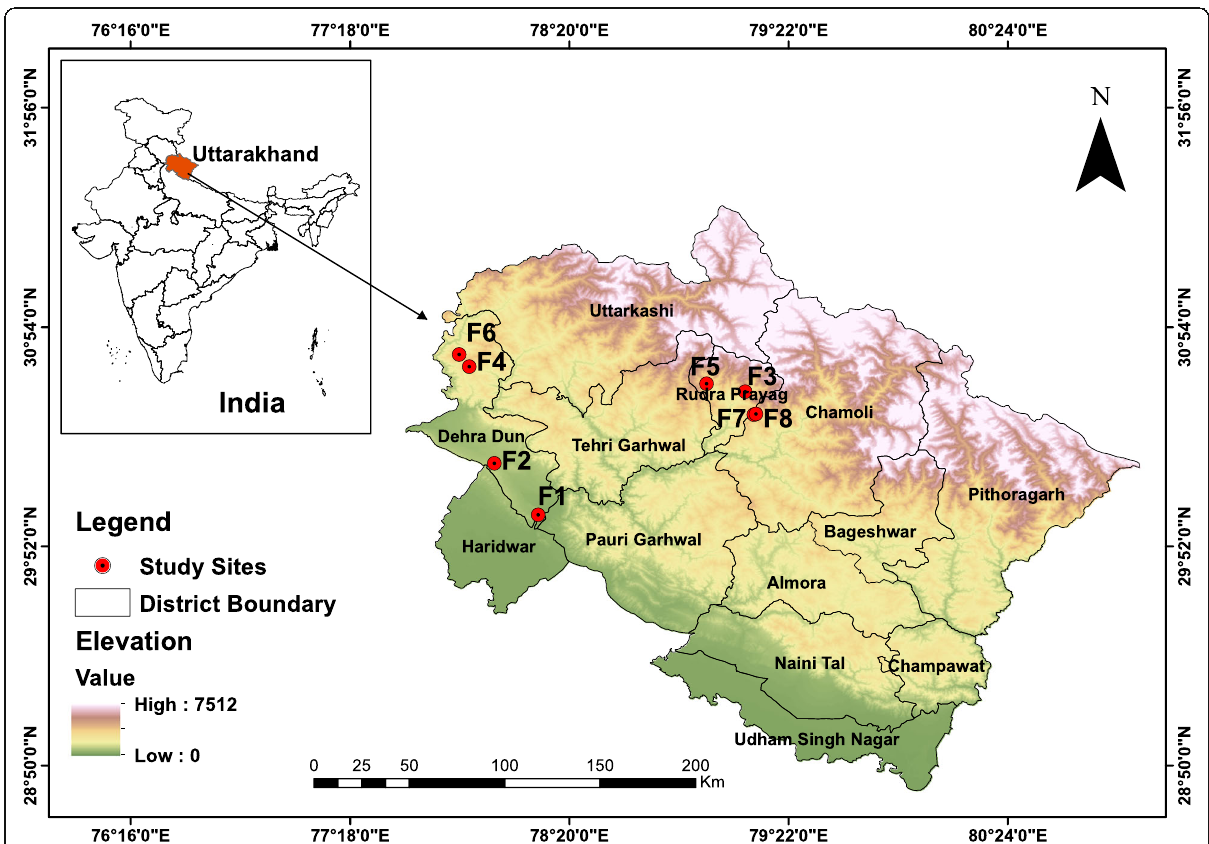
Fig. 1 Elevational gradient map of Uttarakhand representing study sites. F1 – F8 represent the study